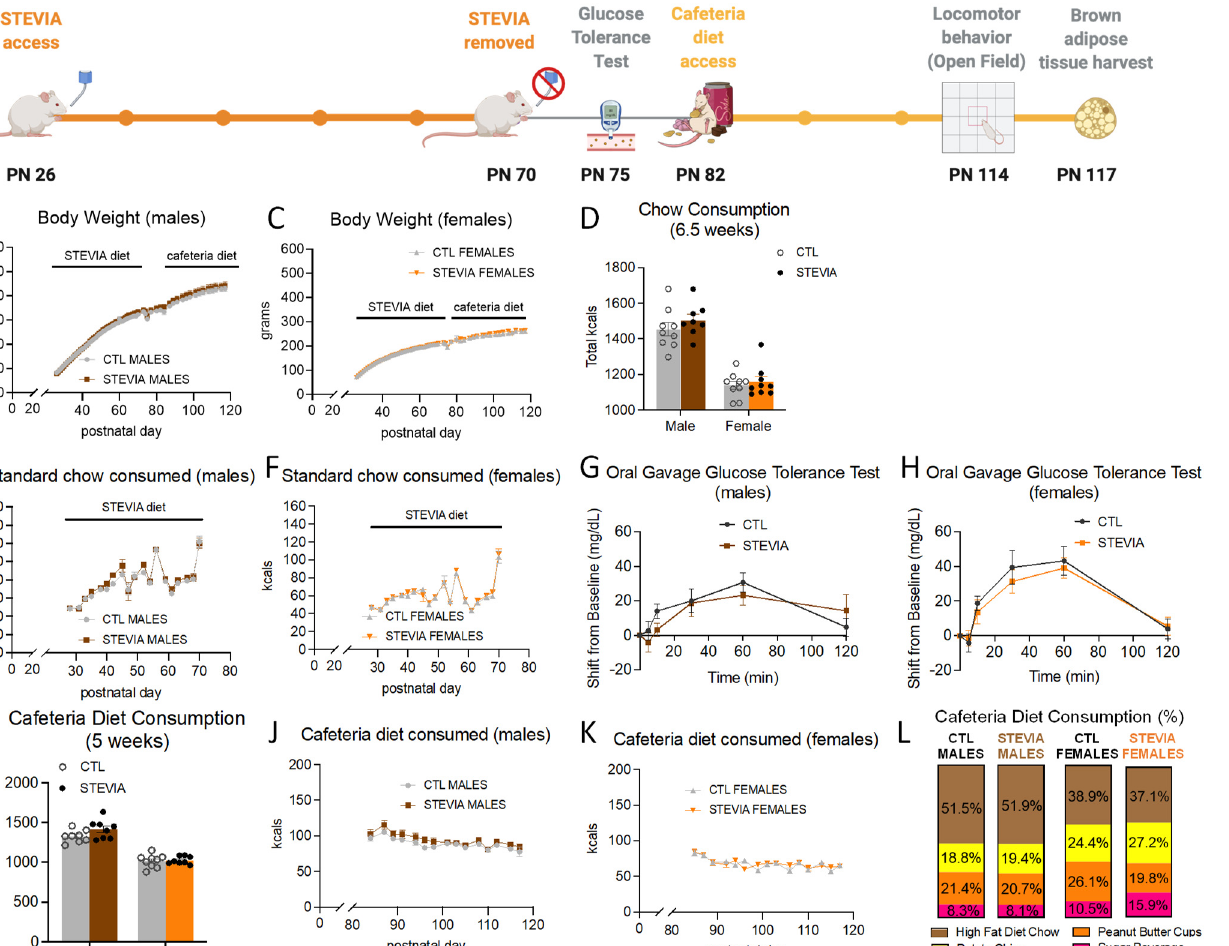
Figure 3. Effects of early life consumption of stevia in rats on energy balance parameters during adulthood. Early life stevia consumption at the ADI (4 mg/kg; ( A )) had no effect on body weight ( B , C ), chow intake ( D – F ), glucose tolerance ( G , H ), or total calories consumed during adult exposure to the cafeteria diet ( I – K ) relative to controls that did not have sugar access during adolescence. There were no significant differences in the percentage of calories consumed from the four cafeteria diet components in either male or female rats ( L ). Early life stevia consumption did not alter the total calories consumed from the cafeteria diet components in male rats during adulthood ( M ), but it did significantly increase the number of calories consumed from the sugar beverage in female rats during cafeteria diet consumption in adulthood – in the absence of differences among the other three cafeteria diet components ( N ). Locomotor activity ( O ) and anxiety-like behavior ( P ) were not influenced by stevia exposure in early life. Data are represented as mean ± SEM, * p < 0.05; PN: postnatal day; CAF: cafeteria; CTL: control; kcal: kilocalories. 3.4. ACE-K Consumption during Early Life Reduces Brown Adipose Tissue Gene Expression of the Thermogenic Markers, BMP8B and UCP1, in Male Rats on a Cafeteria Diet